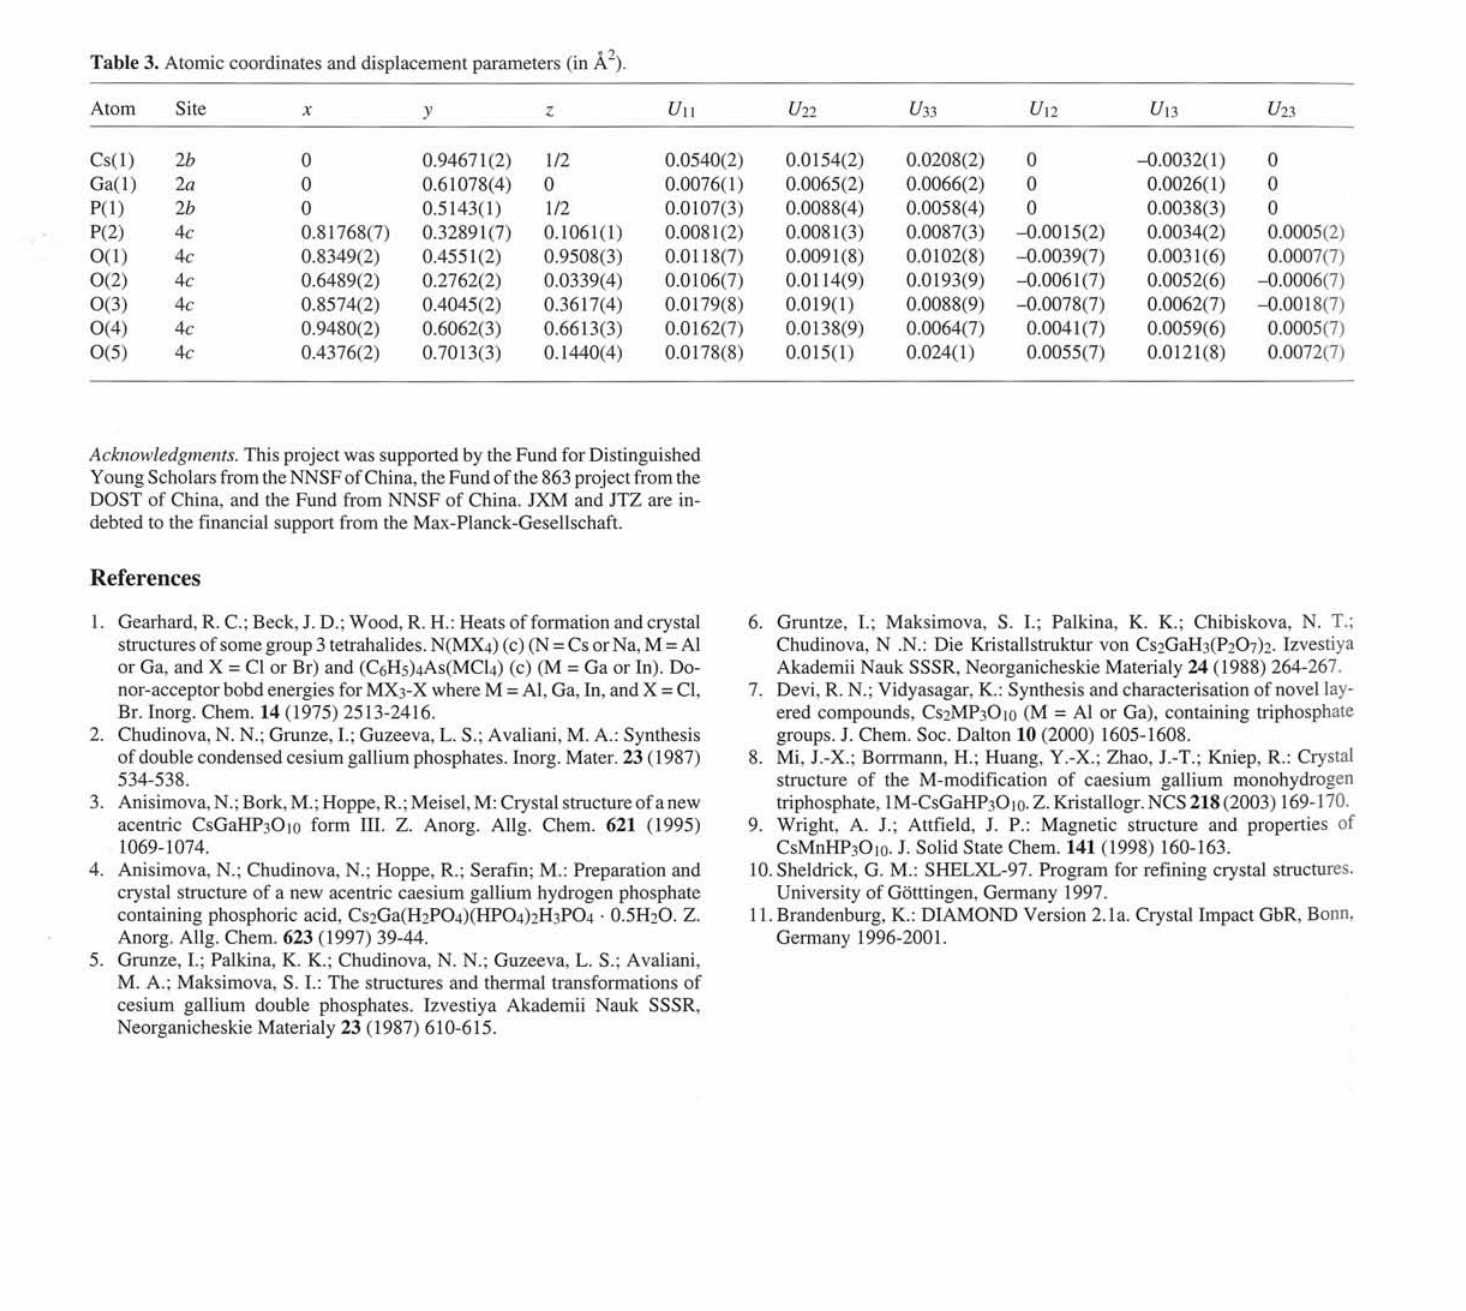
Table 2. Atomic coordinates and displacement parameters (in A").